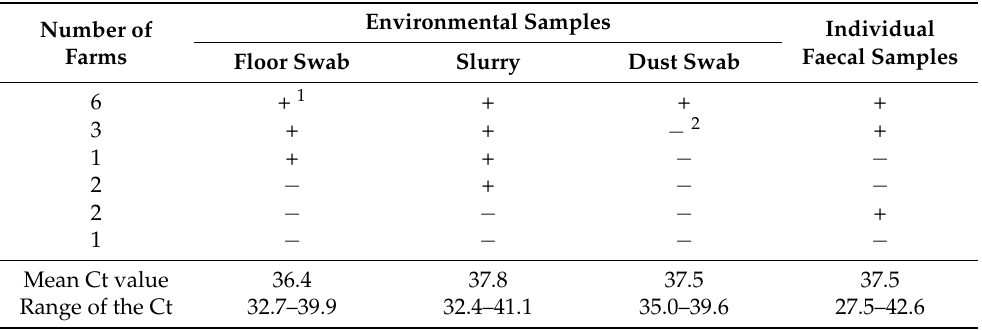
Table 1. Summary of the hepatitis E virus (HEV) RT-qPCR results from the different sample types from all fattening farms and from the rearing and finishing